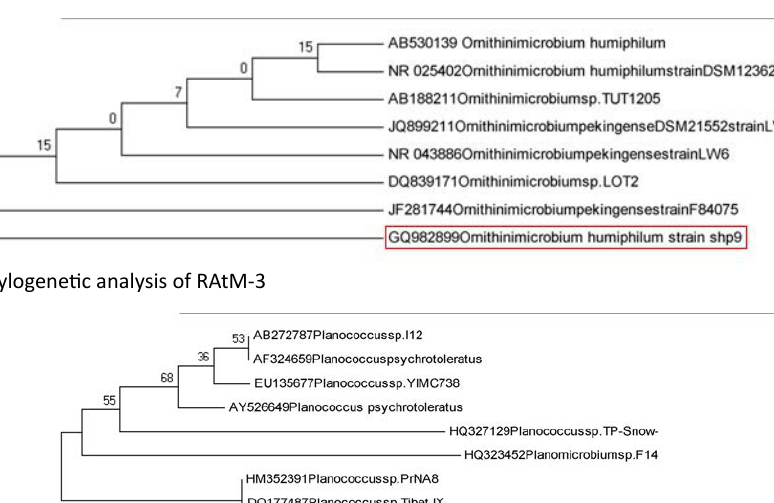
Fig. 8. Phylogenetic analysis of SSL-1